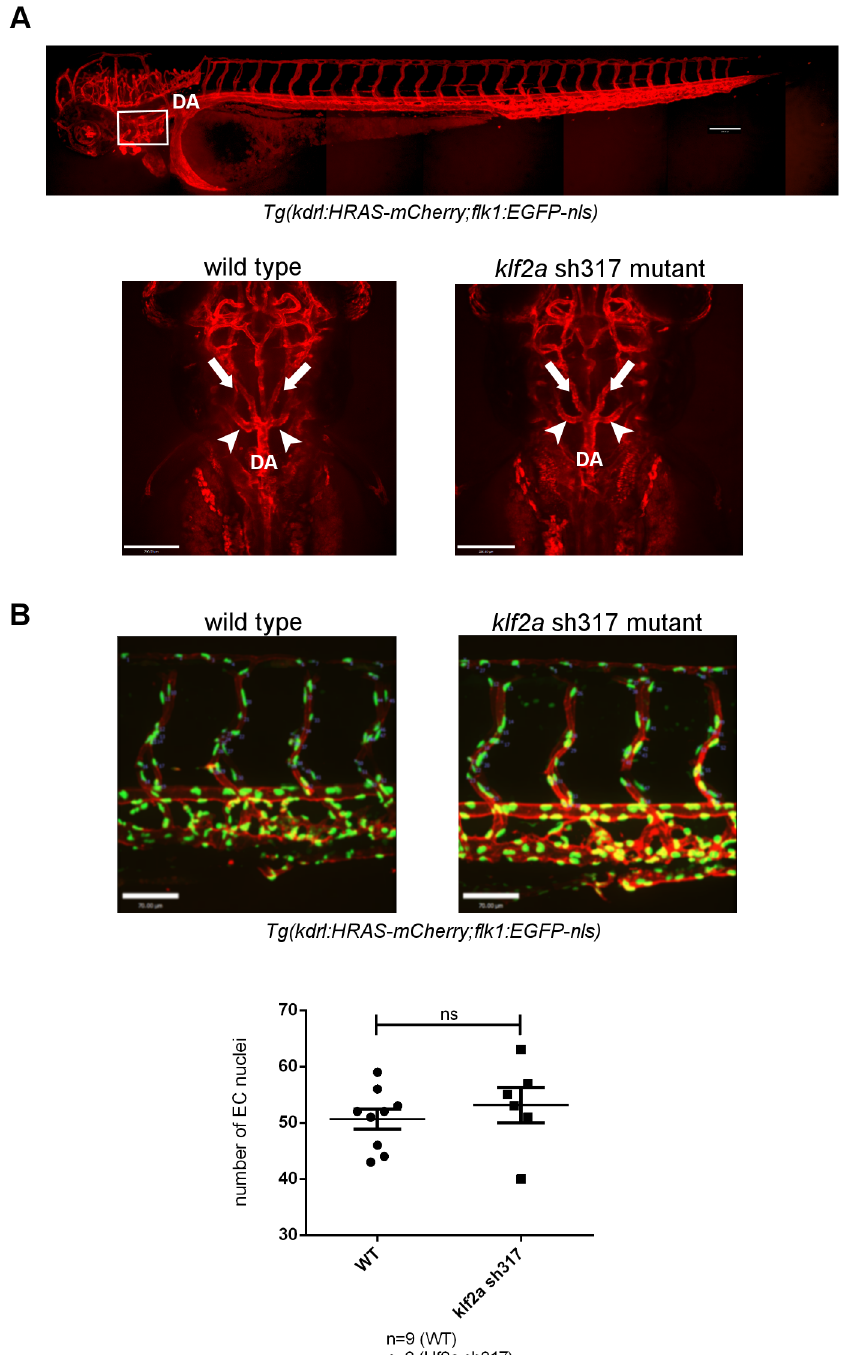
Fig 5. The vascular anatomy of homozygous klf2a sh317 mutants. (A) Formation of the 5 th accessory aortic arch (AA5x) connecting the 5 th and 6 th aortic arch is not affected in homozygous klf2a sh317 mutants. Top panel figure shows vascular anatomy of a zebrafish embryo at 3dpf. White rectangle indicates the location of aortic arches. DA denotes dorsal aorta. Bottom panel figures represent dorsal views on aortic arches. White arrows indicate lateral dorsal aortae. White arrowheads indicate AA5x vessels. Scale bar = 200 μ m. (B) Quantification of endothelial cell nuclei in 4 ISVs closest to the cloaca and corresponding DLAV in WT and klf2a sh317 mutants at 3dpf. Scale bar = 70 μ m.